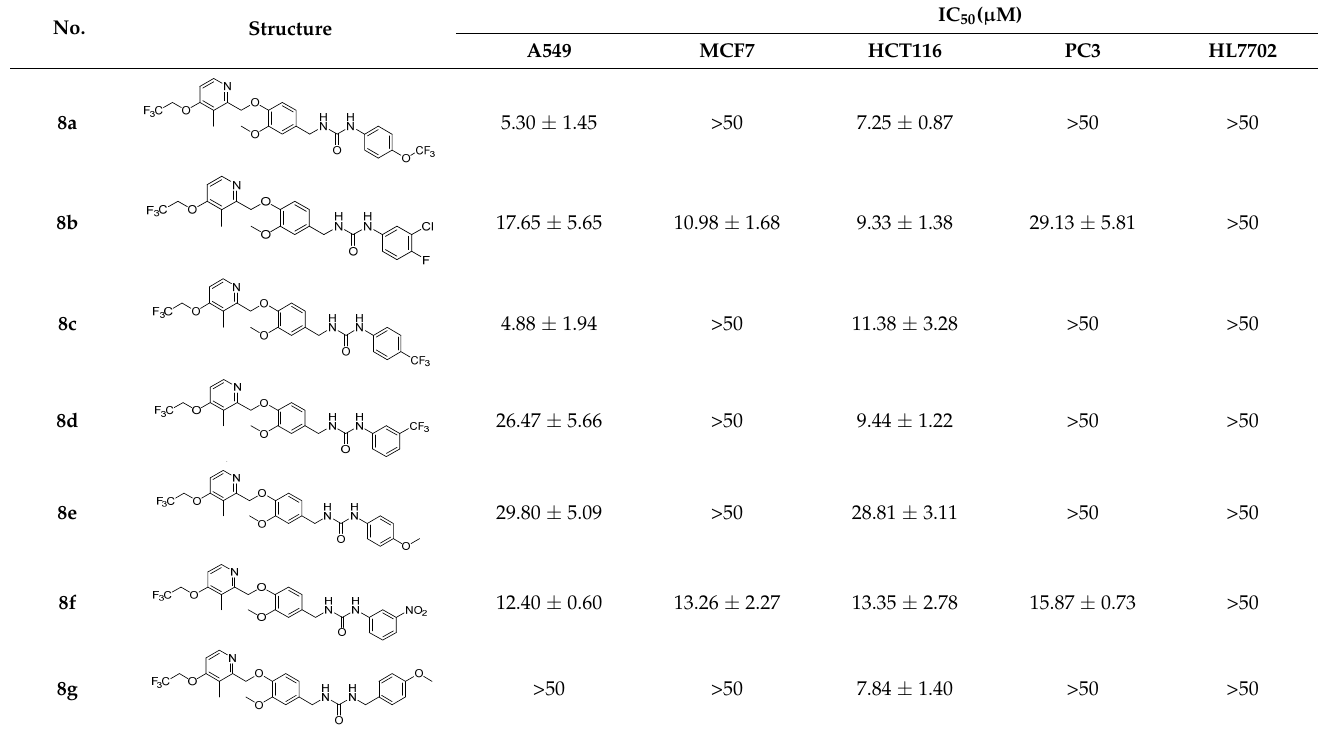
Table 1. The chemical structures and inhibitory activities of the target compounds.